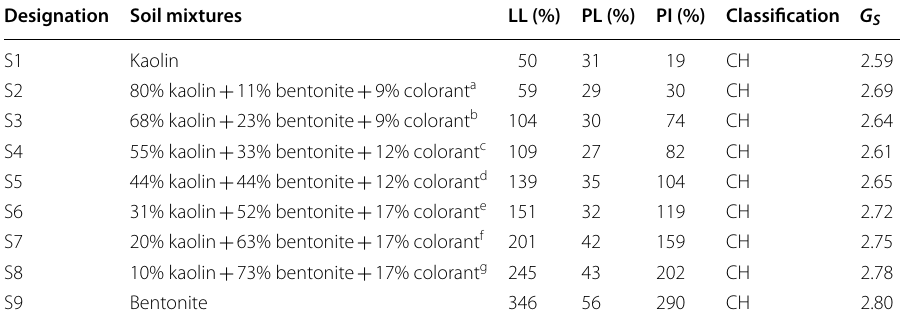
a Yellow; b Combination of 2% red and 7% blue; c Combination of 4% red and 8% blue; d Green; e Red; f Blue; g Black